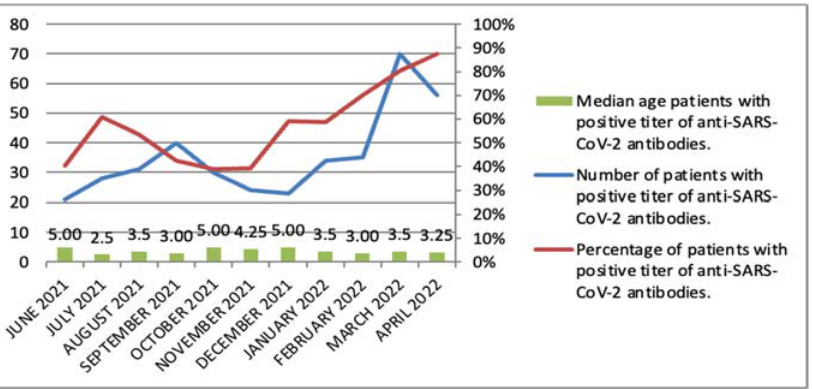
Figure 1. Median age, number, and percentage of patients with positive titer of anti-SARS-CoV-2 antibodies. The presence of detectable anti-SARS-CoV-2 antibodies was more often found in younger age groups. A total of 36% (141 people) were children from 3 to 5 years old, 33.4% (131 people) were children under 2 years of age, 19.1% (75 people) were children from 6 to 10 years of age, and 11.5% (45 people) were children from 11 to 18 years of age. The median age was 3.5